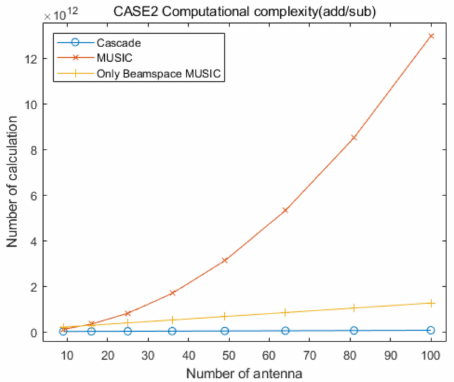
Figure 23. Curves for comparing multiplication / division computational complexities of the proposed cascade algorithm, the general MUSIC algorithm, and only Beamspace MUSIC, versus the number of antenna elements, for CASE 2.